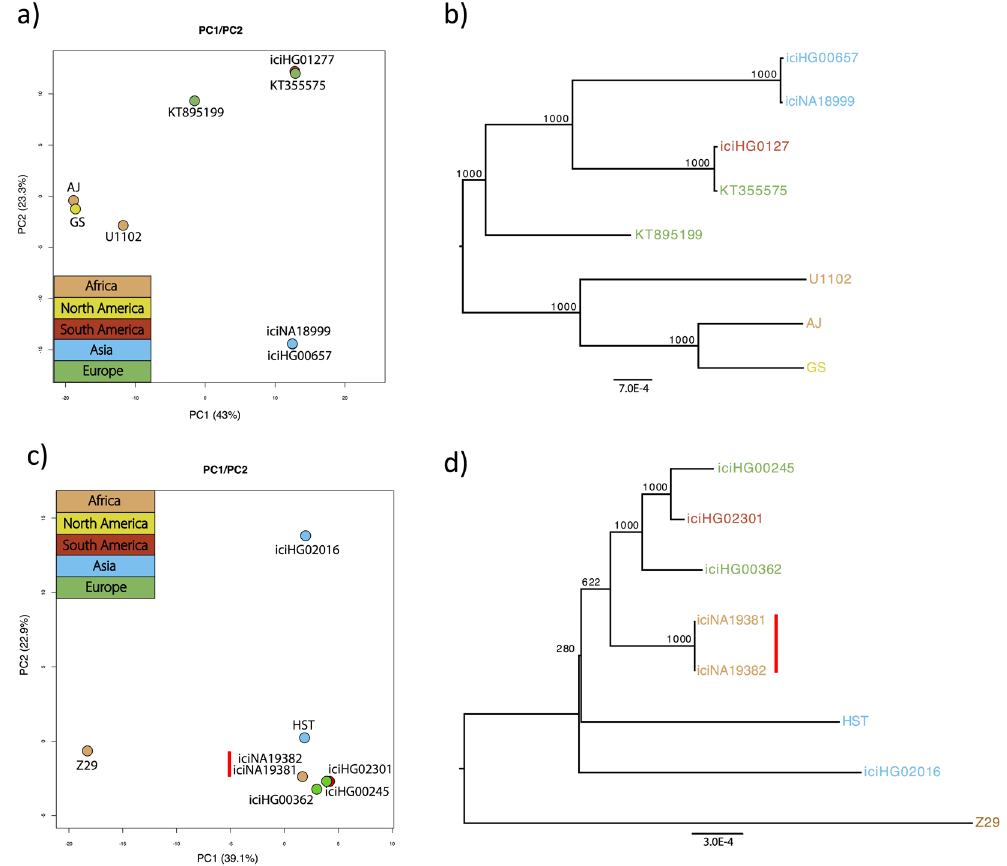
Figure 2. Geographical stratification in HHV-6. ( a) PCA and ( b) Neighbour joining tree, built using all the SNVs in HHV-6A strains. ( c) PCA and ( d) Neighbour joining tree, built using all the SNVs in HHV-6B strains. Individuals are color-coded based on the geographical origin. The vertical red line indicates the first-degree family members